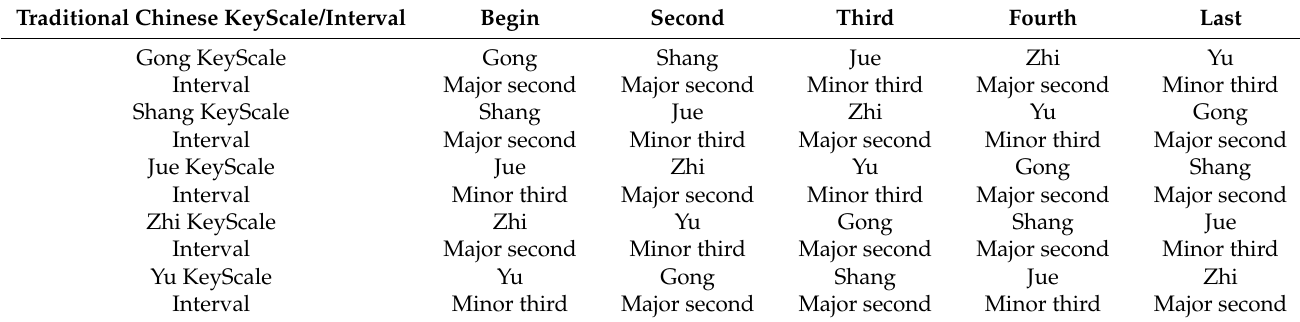
Table 5. The interval relationship of the traditional Chinese pentatonic scales.